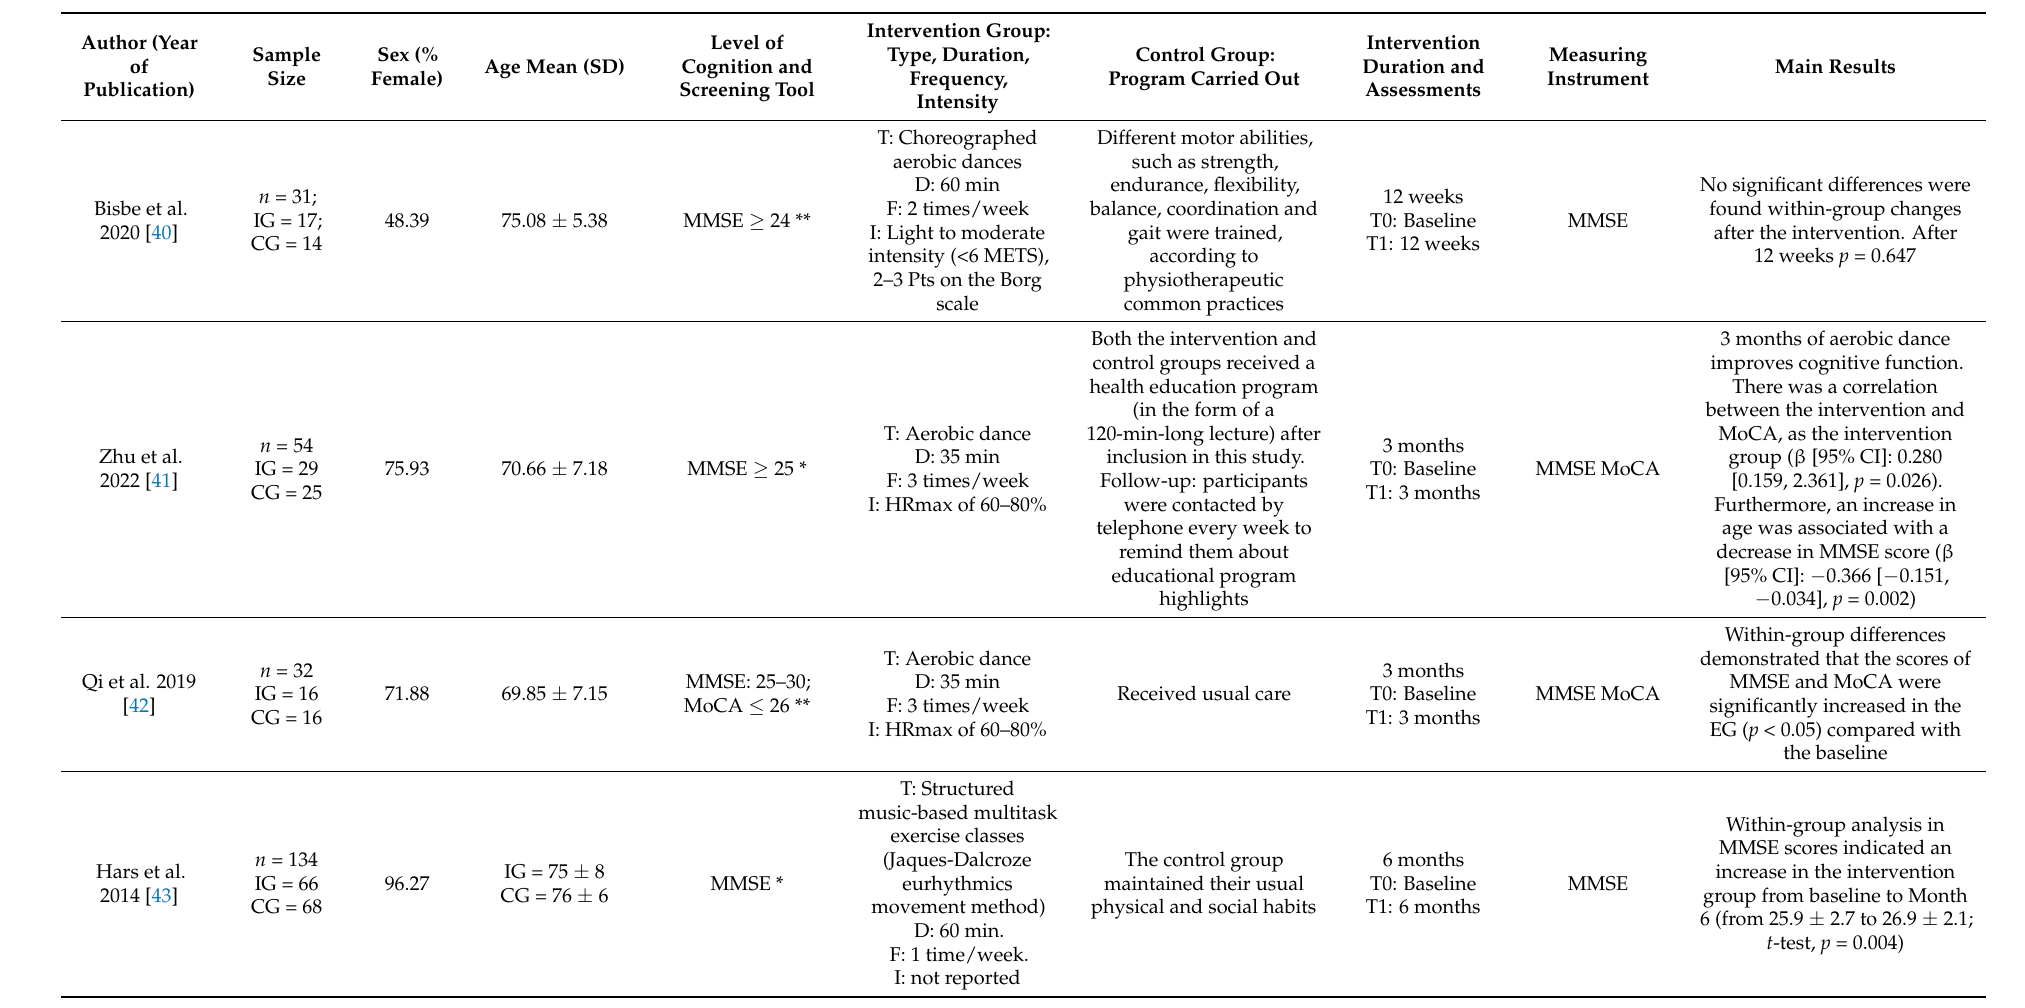
Table 2. Characteristics of the included